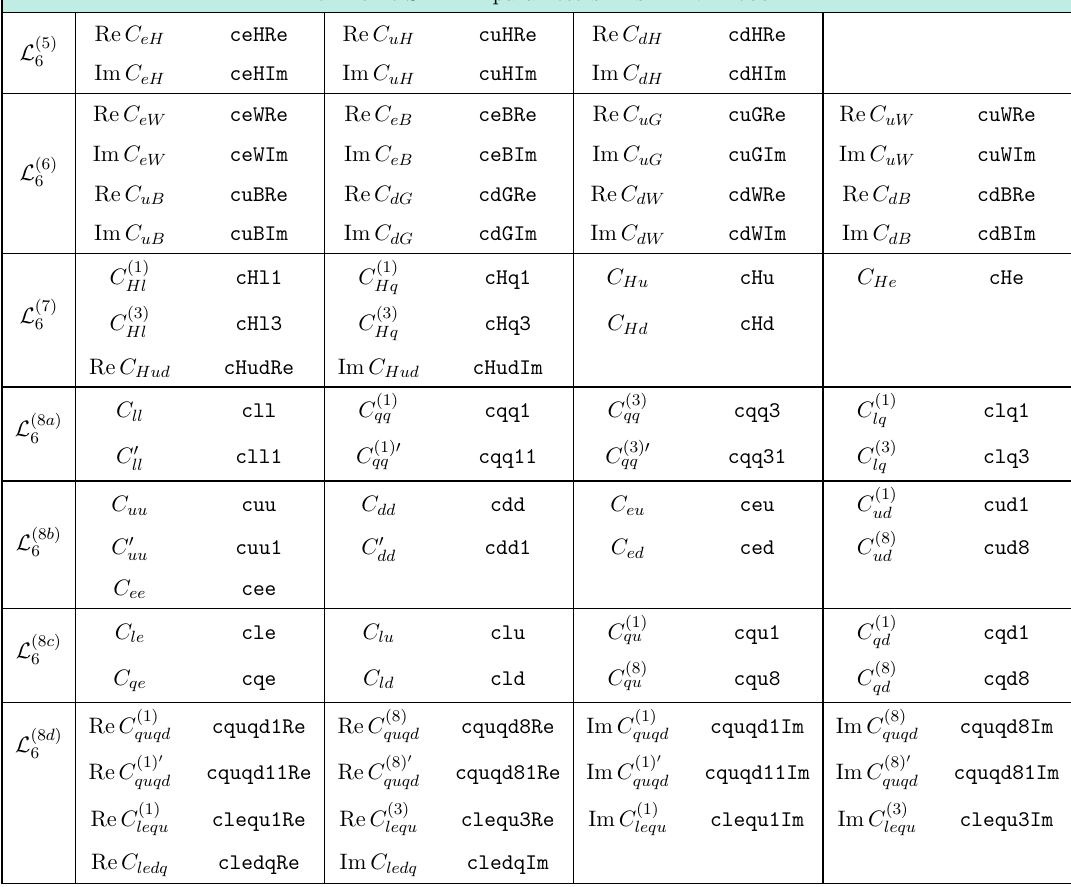
defined in the U35 model, see section 6